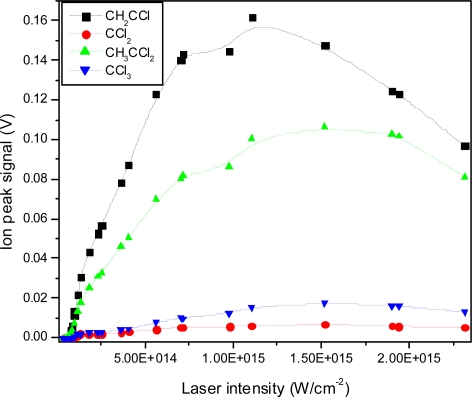
Ion peak signals as a function of laser intensity for CH2C35Cl+, C35Cl2+, CH3C35Cl2+, C35Cl3+ fragment ions using 795 nm laser radiation with 150 fs pulse duration.